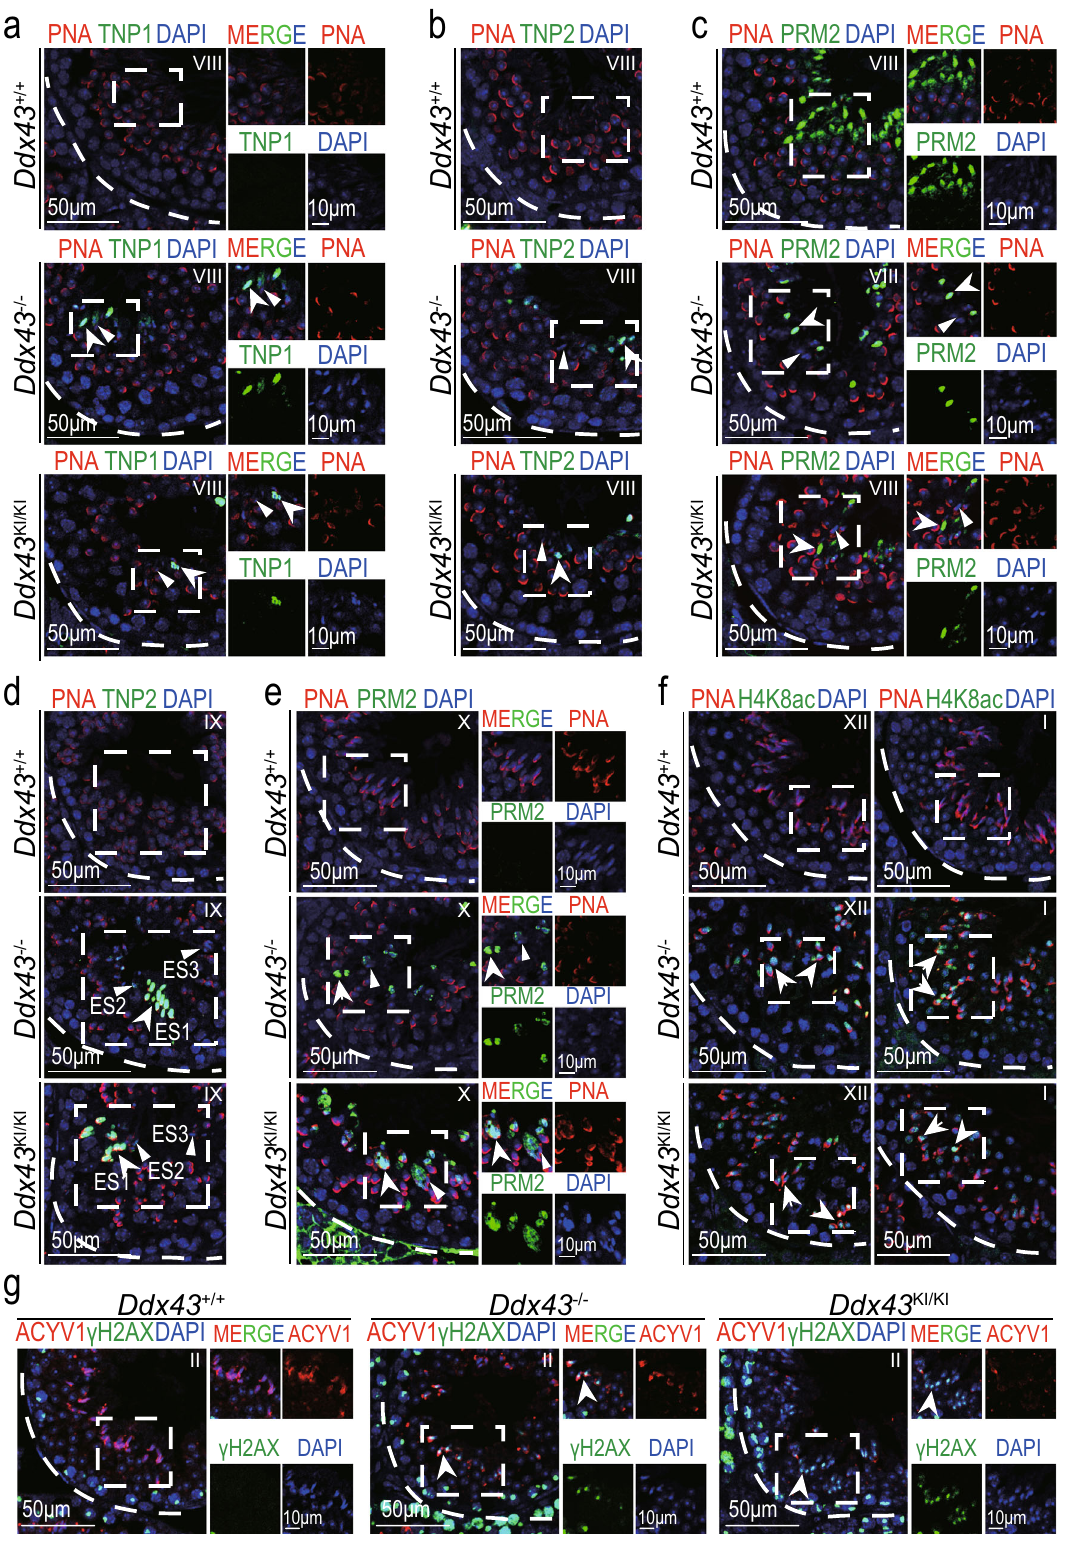
Fig. 3 | DDX43 de fi ciency impairs chromatin remodeling during spermiogen- esis. a – g Immuno fl uorescence analyses on adult Ddx43 +/+ , Ddx43 KI/KI and Ddx43 – / – mouse testes with the following combinations. a TNP1 (green) and PNA (red), see also Supplementary Fig. 4a; ( b , d ) TNP2 (green) and PNA (red), see also Supple- mentary Fig. 4b; ( c , e ) PRM2 (green) and PNA (red); ( f ) H4K8ac (green) and PNA (red), see also Supplementary Fig. 5a, b; ( g ) γ H2AX (green) and PNA (red). Right